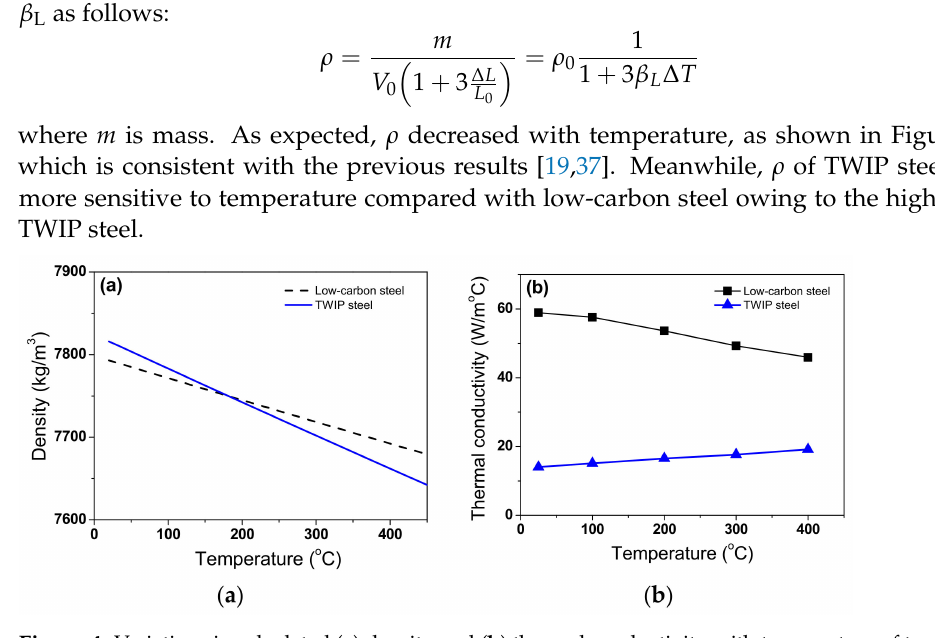
Figure 4. Variations in calculated ( a ) density and ( b ) thermal conductivity with temperature of two steels.